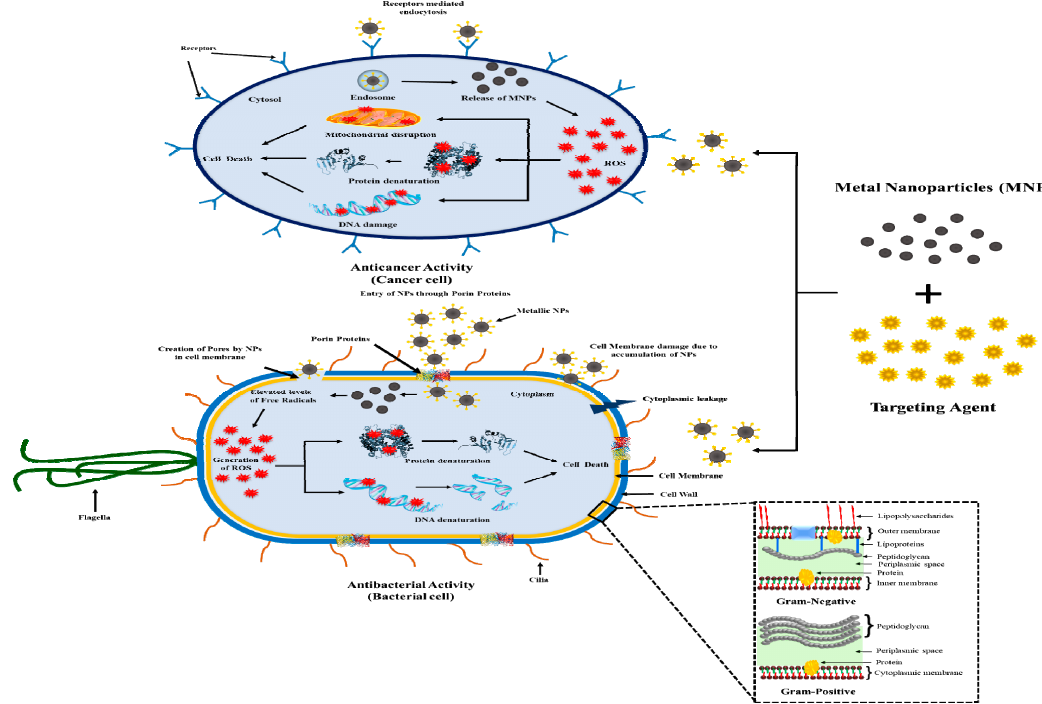
Figure 3. Graphical representation of mechanism showing anticancer and antimicrobial activity.